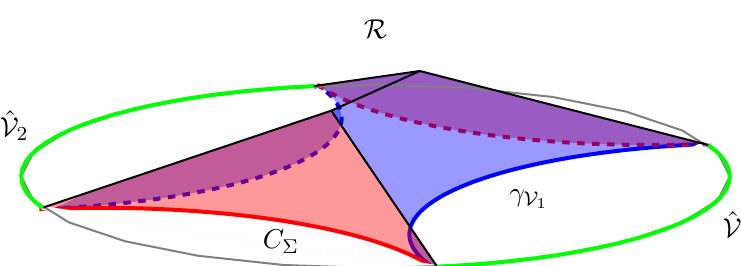
Figure 6. The null membrane. The blue surface is the lift L , which is generated by the null geodesics defined by the inward, future pointing null normals to γ Takayanagi surface for region ˆ V . The red surfaces make up the slope S i the null geodesics defined by the inward, past directed null normals to γ where null rays from γ and γ collide. The contradiction surface C V 1 V 2 specified Cauchy surface Σ